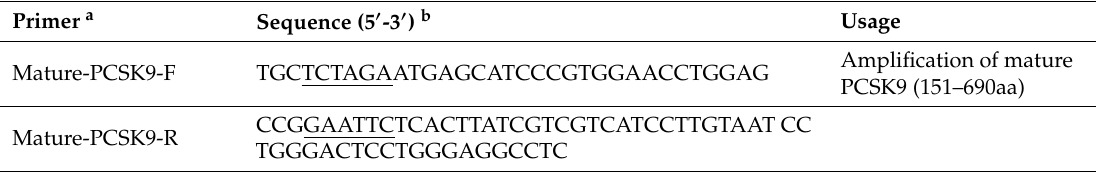
Table 1. Primers used in this